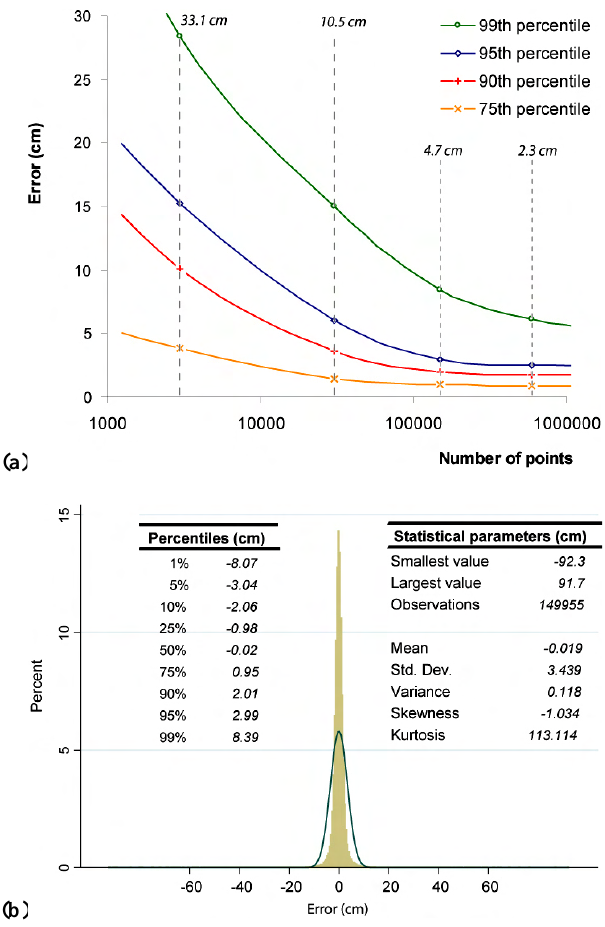
Fig. 4. Assessment of the quality of rock face modelling. (a) Variance of the population assessed for different densities of points through the percentiles of the error of the model comparison; (b) probability distribution of the error of the model comparison using a mean point spacing of 4.7cm. The histogram is characterized by considerable kurtosis and a poor resemblance to a fitted Gaussian distribution (blue line). See text for a detailed